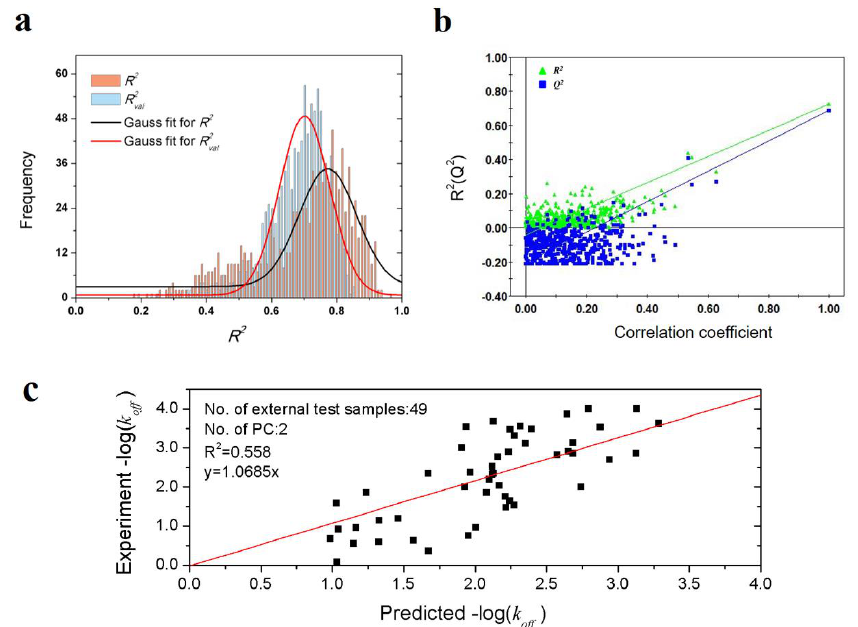
Figure 3. Results of PLS model validation. ( a ) R 2 and R 2 val distributions of 1000-times repeated PLS modeling; ( b ) 500-times Y random permutation test; ( c ) scatter plot of experimental vs. predicted −log( k off ) of 49 independent test samples.